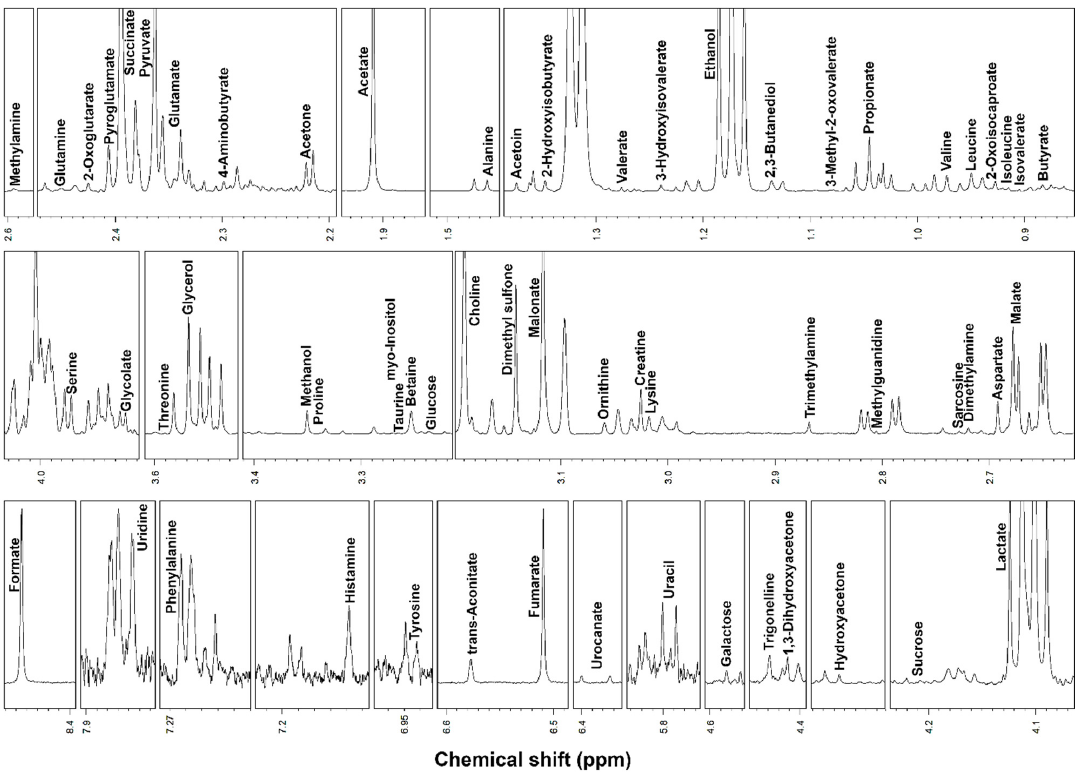
Figure 2. Portions of 1 H-NMR spectra from typical saliva samples. Assignments appear on the signals used for molecules quantification. The vertical scale of each portion is conveniently set to ease the signals observation.